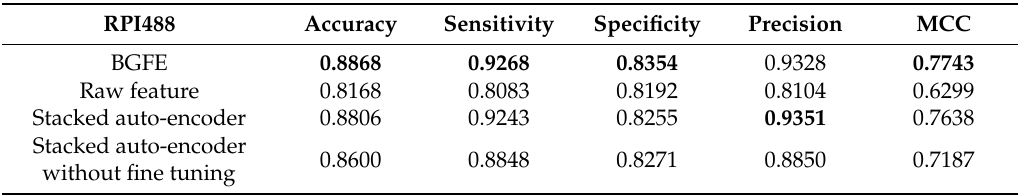
Table 2. Specific Performance of Four Methods on Dataset RPI488.